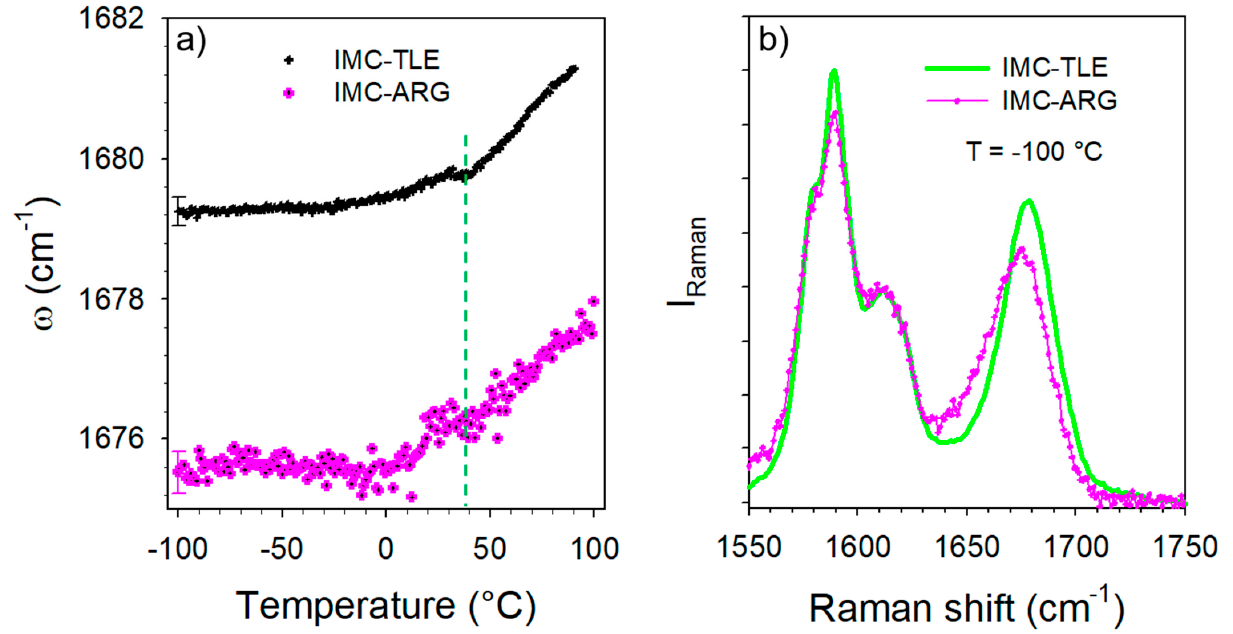
Figure 9 . Temperature dependence of the band distinctive of the H-bonding in the IMC–TLE and IMC–ARG blends. ( a ) T-dependence of the frequency—only one error bar was reported for better clarity. ( b ) Spectrum collected at − 100 °C in the IMC–TLE and IMC–ARG blends .